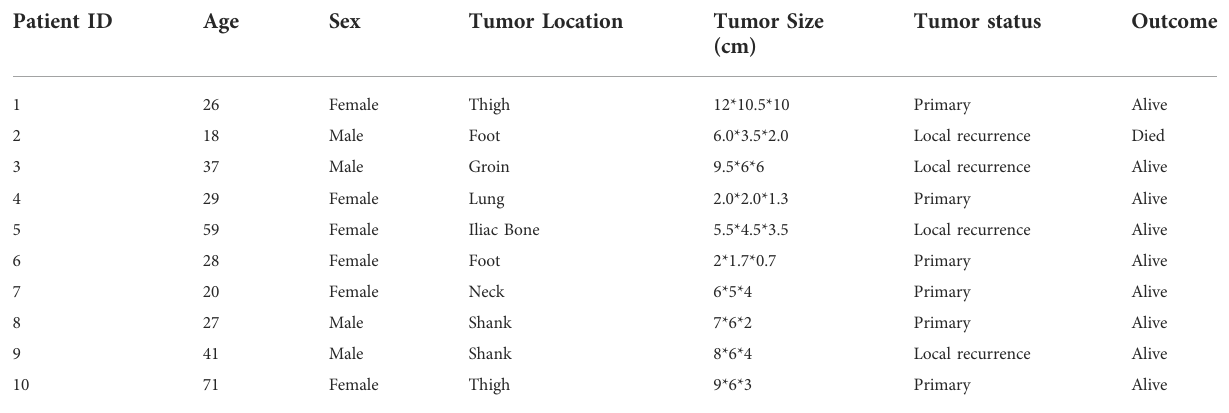
TABLE 1 Detailed information of 10 synovial sarcoma